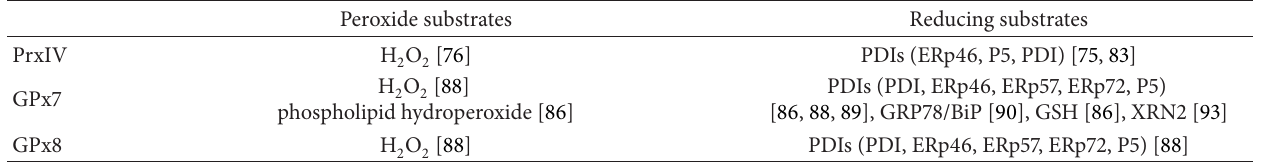
Table 1: Published peroxide and reducing substrates of ER-resident